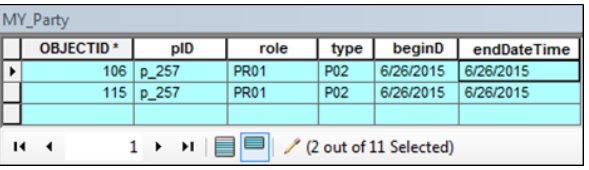
Figure 5. The result of query in MY_Party table